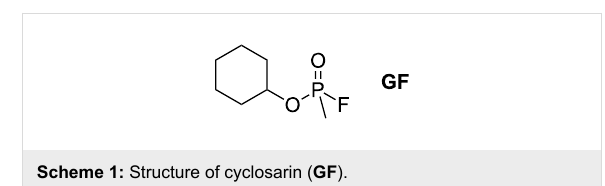
Scheme 1: Structure of cyclosarin ( GF